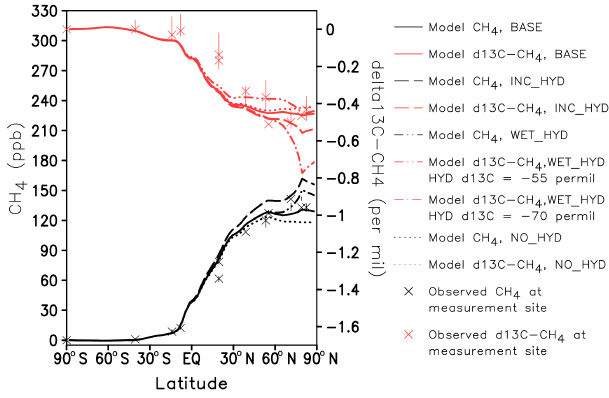
Figure 9. The difference between surface annual mean modelled latitudinal gradients in CH 4 and δ 13 C-CH 4 and South Pole annual mean values. Model results are compared to NOAA-ESRL and CU- INSTAAR observations. Black represents CH 4 mixing ratios, and red represents δ 13 C-CH 4 fractionations. Where there are sufficient data available in the 2005–2009 period, the range in annual mean station South Pole observed differences is represented by a vertical bar. Solid lines represent model results from the BASE emission scenario. Dashed lines represent model results from the INC_HYD scenario (where hydrate emissions have been increased by 12 to 17Tgyr − 1 relative to BASE). Dotted lines represent model results from the NO_HYD scenario (where emissions from methane hy- drates are removed relative to BASE). Dot-dash lines show model results from the WET_HYD scenario (where hydrate emissions are increased by 12 to 17Tgyr − 1 and wetland emissions >50 ◦ N are reduced by 12Tgyr − 1 relative to BASE). Dot-dot-dash lines repre- sent emission magnitudes as for the WET_HYD scenario but with an isotopic fractionation for hydrate emissions of −